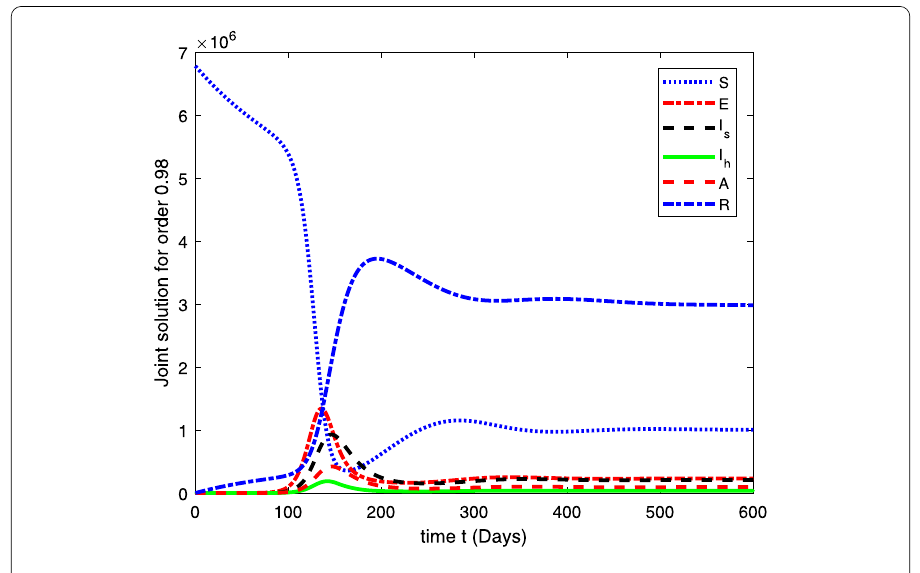
Figure 3 Joint solution of COVID 19 model (1) for the order 0.98